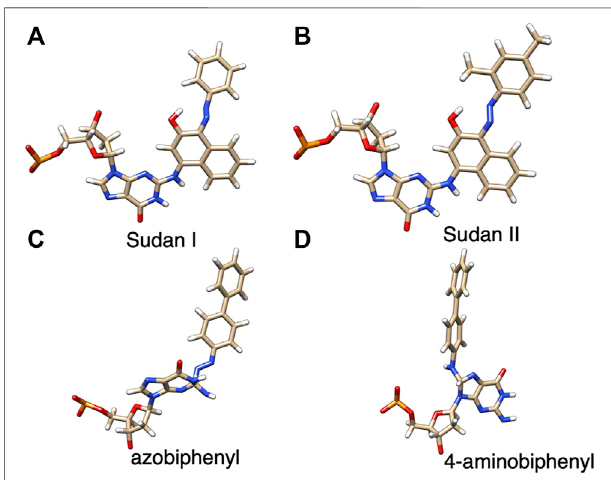
FIGURE 1 | Structures of dG adducts with (A) Sudan I, (B) Sudan II, (C) azobiphenyl, and (D) 4-aminobiphenyl, where red, oxgyen; blue, nitrogen; brown, carbon; orange, phosphorus; and white,